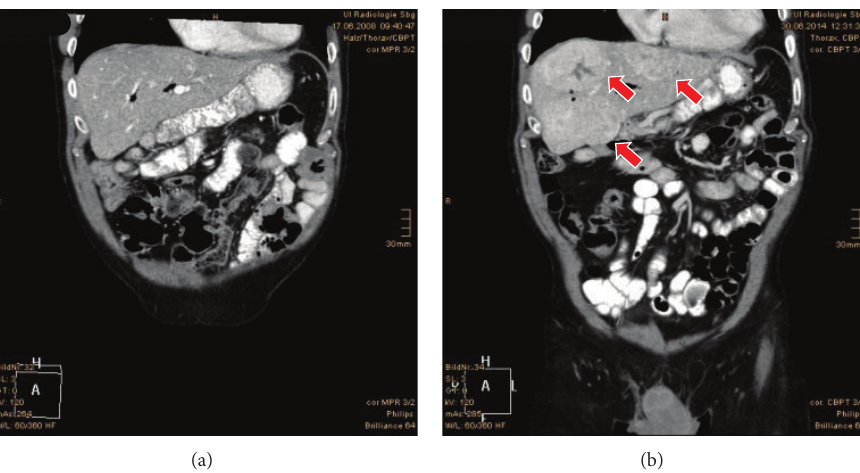
Figure 2: (a) Abdomen CT coronal view showing no evidence of metastasis after multiple metastasectomies. The scan was performed in 2008. (b) A recent (2014) picture of the same view showing multiple liver metastases (red arrows) before starting the 8th systemic targeted